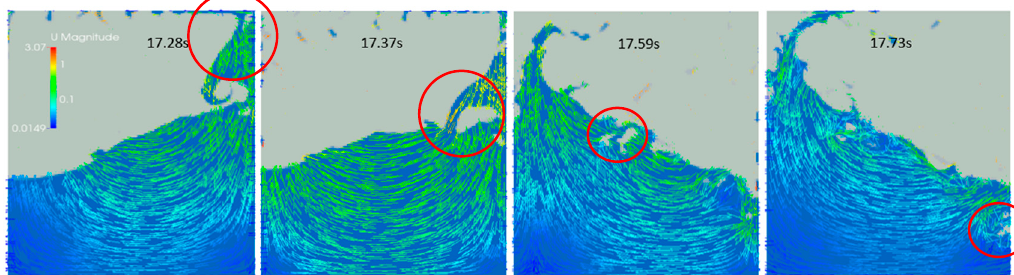
Figure 20. The fluid phenomenon in shallow water sloshing (h/L = 0.1, ω / ω 1 = 1.1, A = 7 mm, the falling liquid hits the free surface in the red circle).